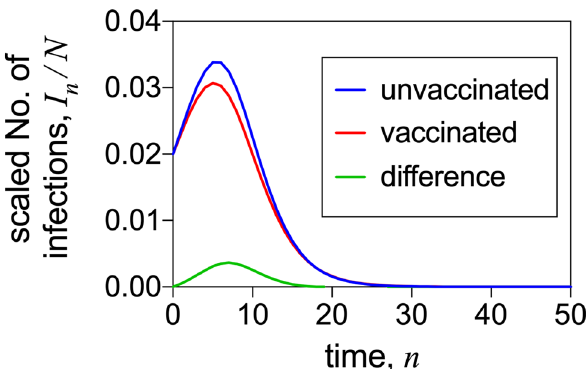
Figure 1. Number of infected individuals. We plot infection numbers, as a function of the discrete time, n , in the presence and absence of vaccination. The ratio plotted, I n / N , is independent of both the mortality rate, m , and the initial population size, N , hence the figure applies for any values of m and N . The peak value of the number of infections is proportional to both the maximum number of individuals hospitalised and also the maximum number of individuals that die at any time. The parameter values adopted for the figure are: vaccination rate ν = 0.02 , initial prevalence of the disease p = 0.02 , and basic reproduction number R = 1.2